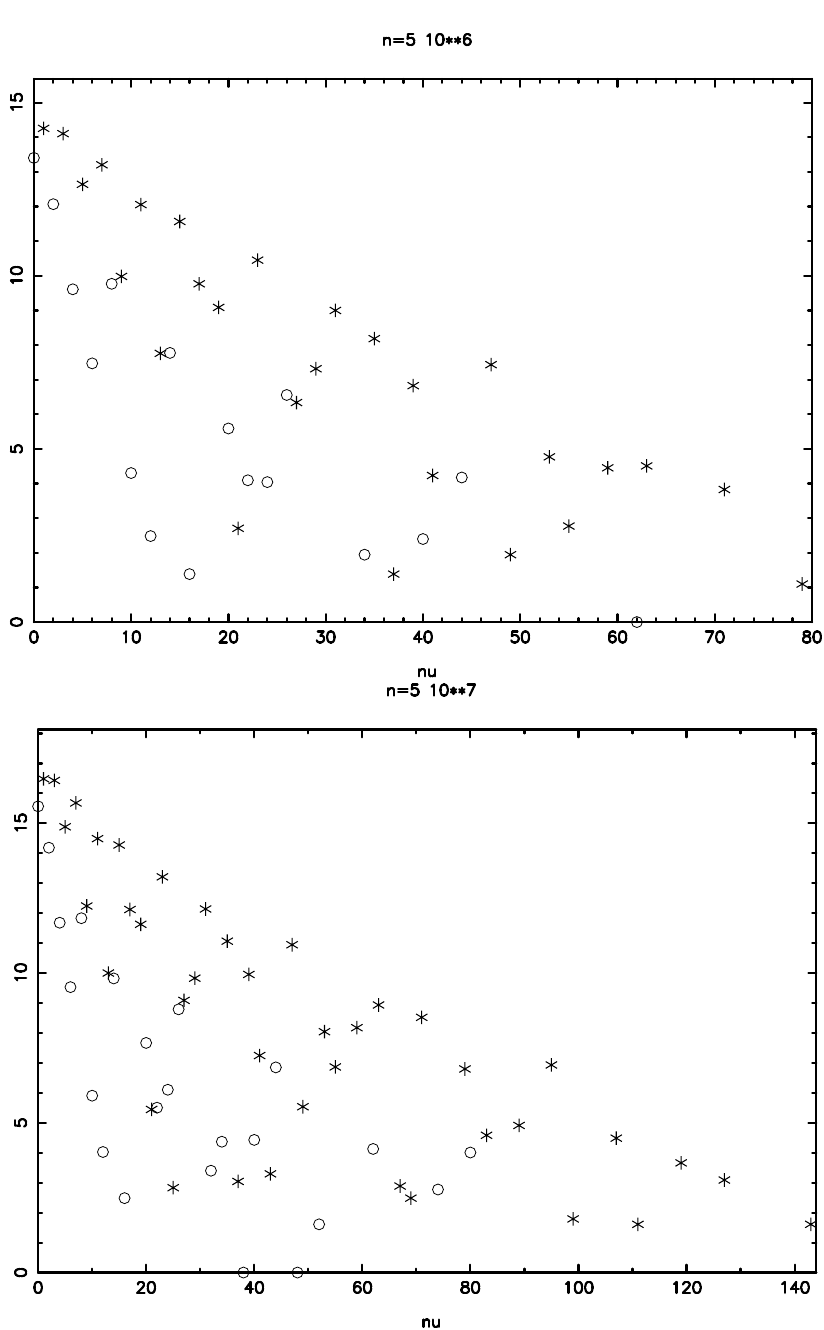
Figure 5: Distribution ln (Π asterisk: cods